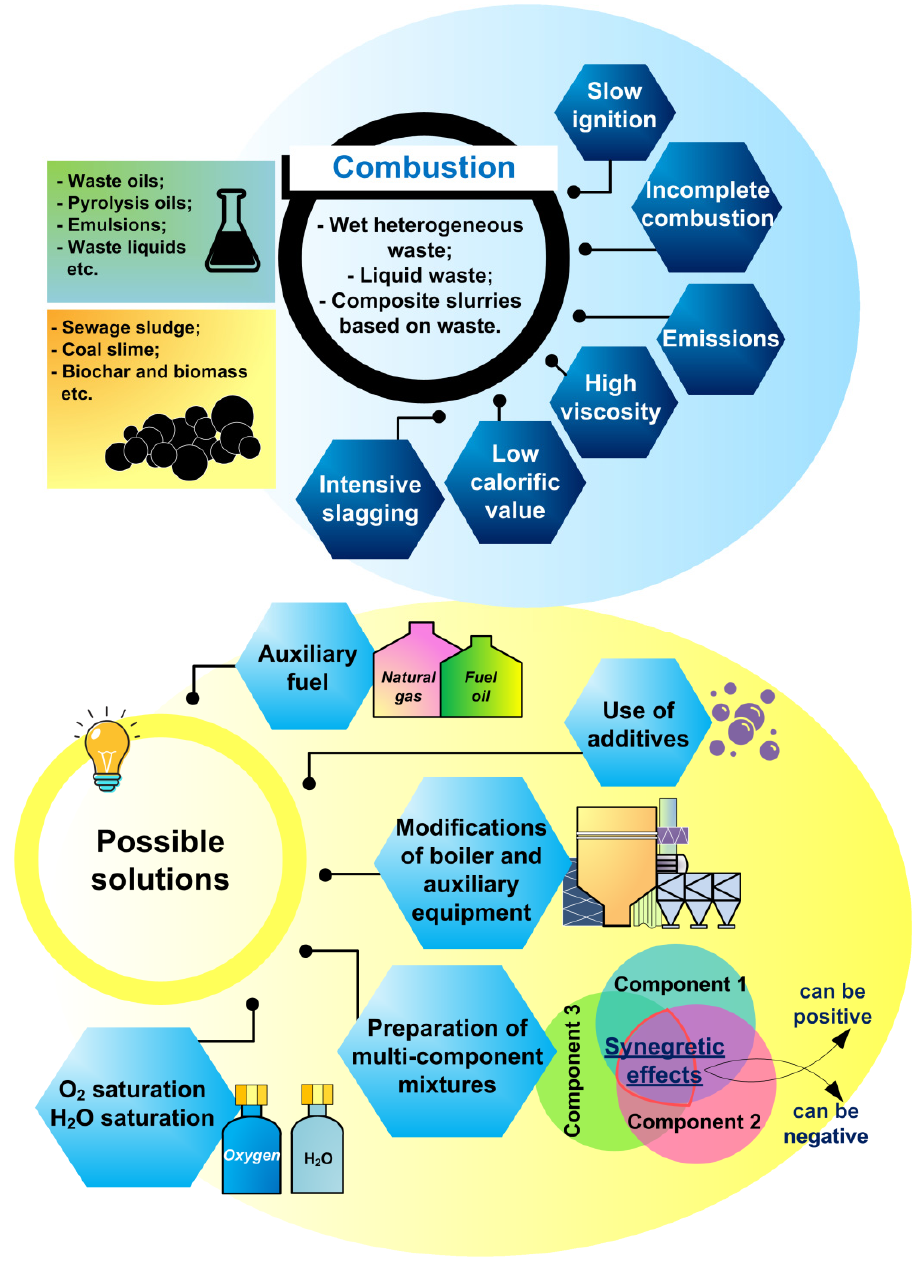
Figure 3. Features of combustion of low-grade high-moisture, slurry, and liquid